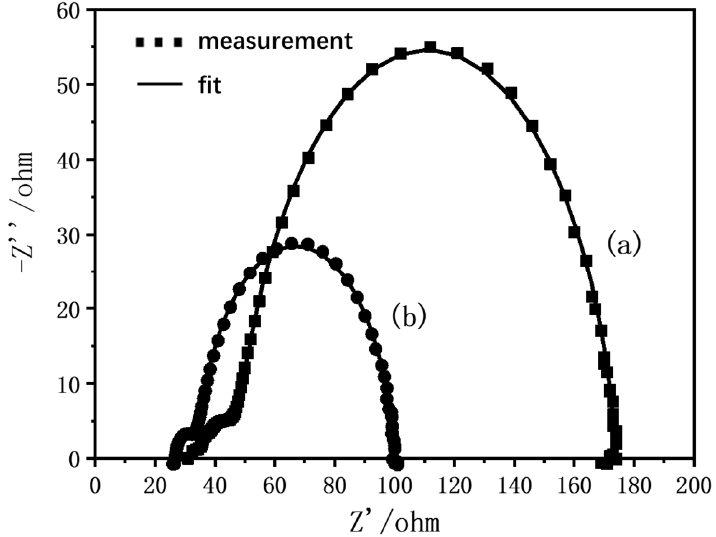
Figure 12. EIS results of DSC after assembly of anode films: (a) without modification; (b) modified by soaking in 40 mM TiCl 4 aqueous solution at 70 °C for 30 min. Table 2. Electron transport kinetics microscopic parameters of DSC before and after adding TiO 2 particle surface ‐ modification layer.